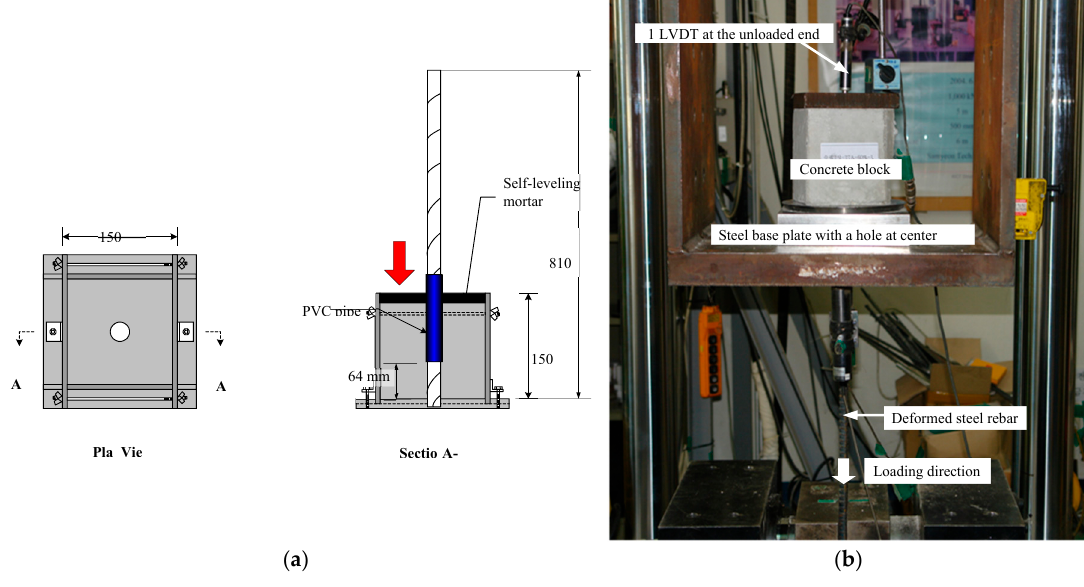
Figure 3. Pull-out test. ( a ) Typical test specimen (V-type); ( b ) Test set-up.